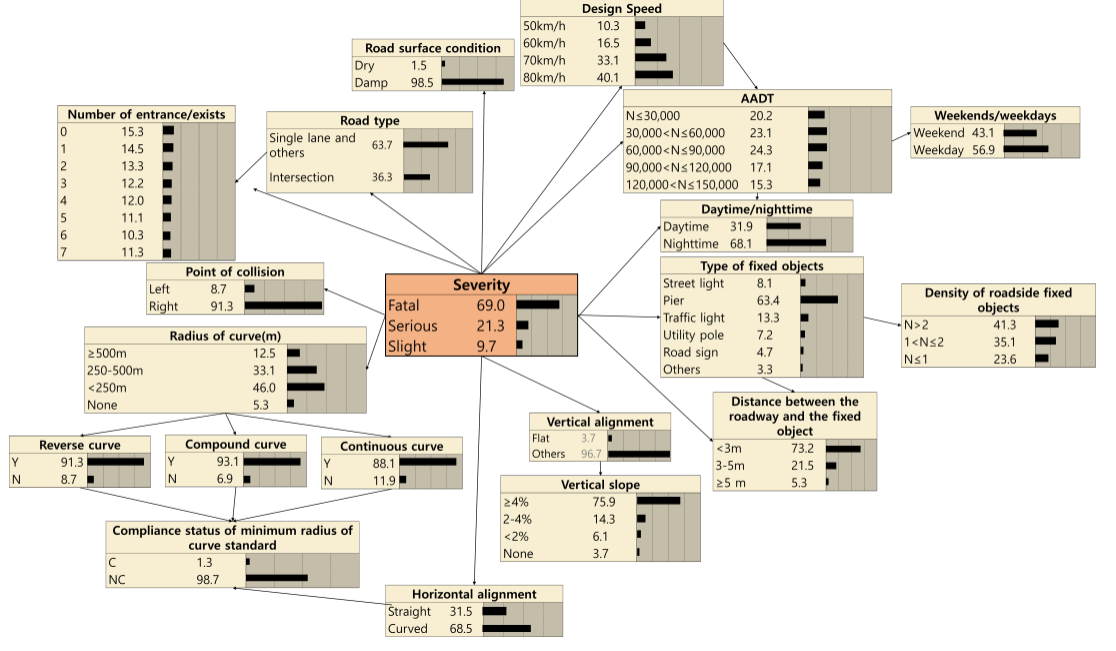
Figure 5. RORC severity prediction model.